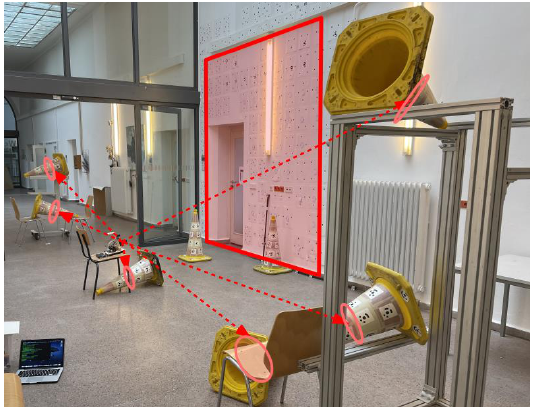
Figure 4 . Reference field consisting of (non)-coded targets on the wall (CAM) and with coded targets signalized cones (LS) A wall signalized with measurement marks on a large scale for the determination of the camera positions (Figure 4 red square) and a spatial measurement field for the 2D laser scanner consisting of cones signalized with coded measurement marks (Figure 4 light red ellipses) were combined to one reference field.